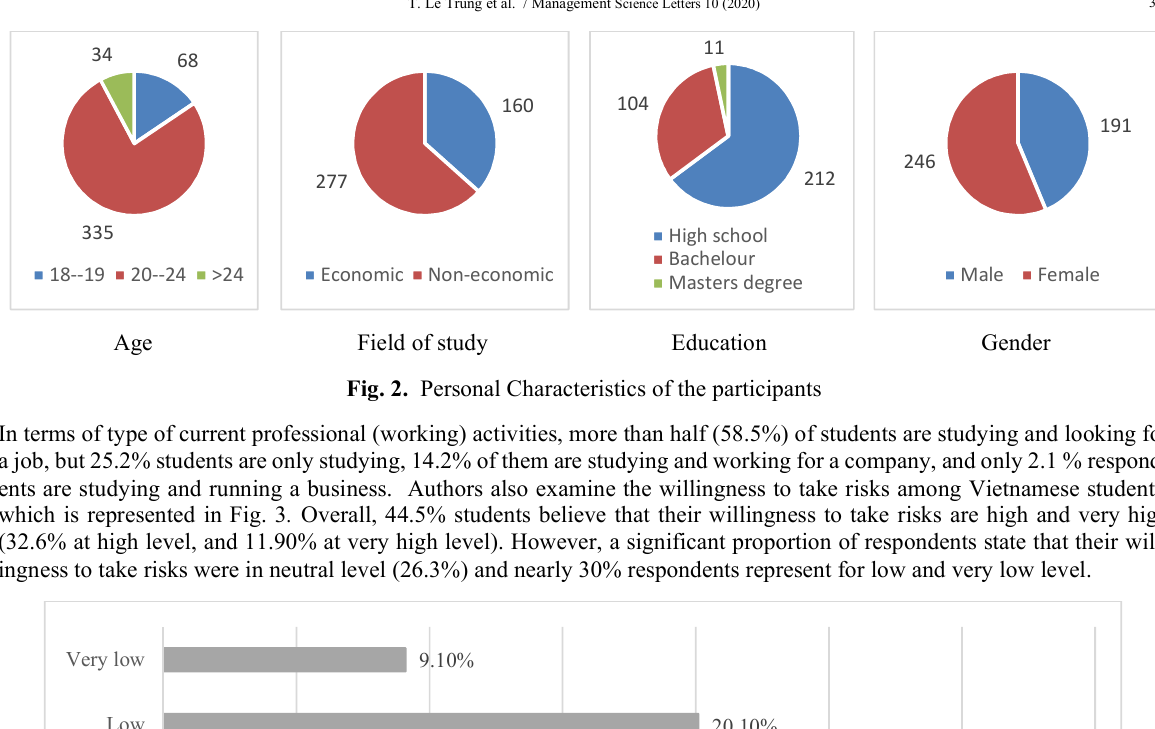
Descriptive statistics of variables